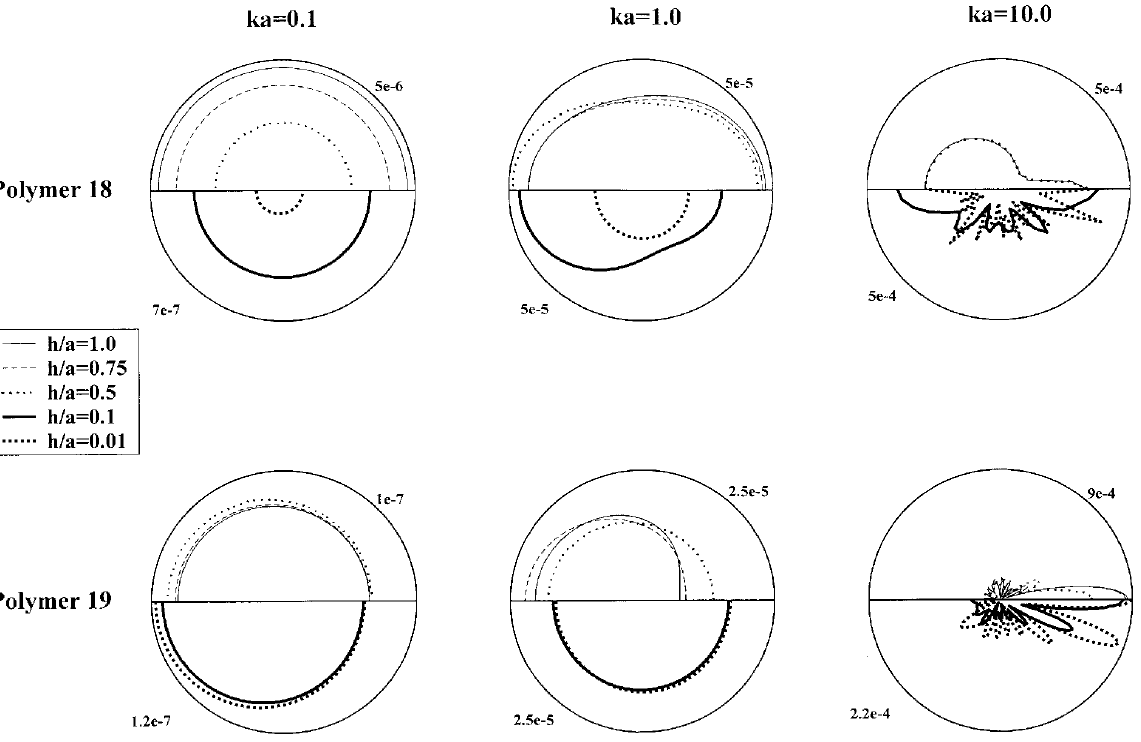
Fig. 7. Angular distribution of the scattered far-field pressure due to normal incidence of a unit amplitude plane wave on an olive oil-filled cylindrical viscoelastic shell immersed in glycerine for selected dimensionless wave numbers and shell thicknesses. ( P 0 = 1 . ) incident upon an olive oil-filled spherical viscoelastic shell immersed in glycerineat selected dimensionless wave numbers and shell thicknesses. The far-field value of the radial coordinate in each case was simply chosen by making several computer runs while seeking for the convergence of the scattered pressure directivity